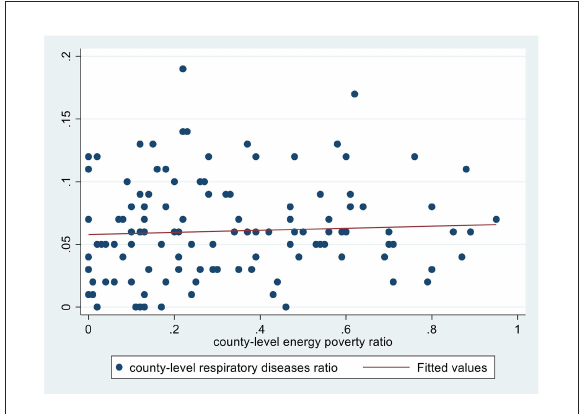
FIGURE5 Energy poverty and healthcare